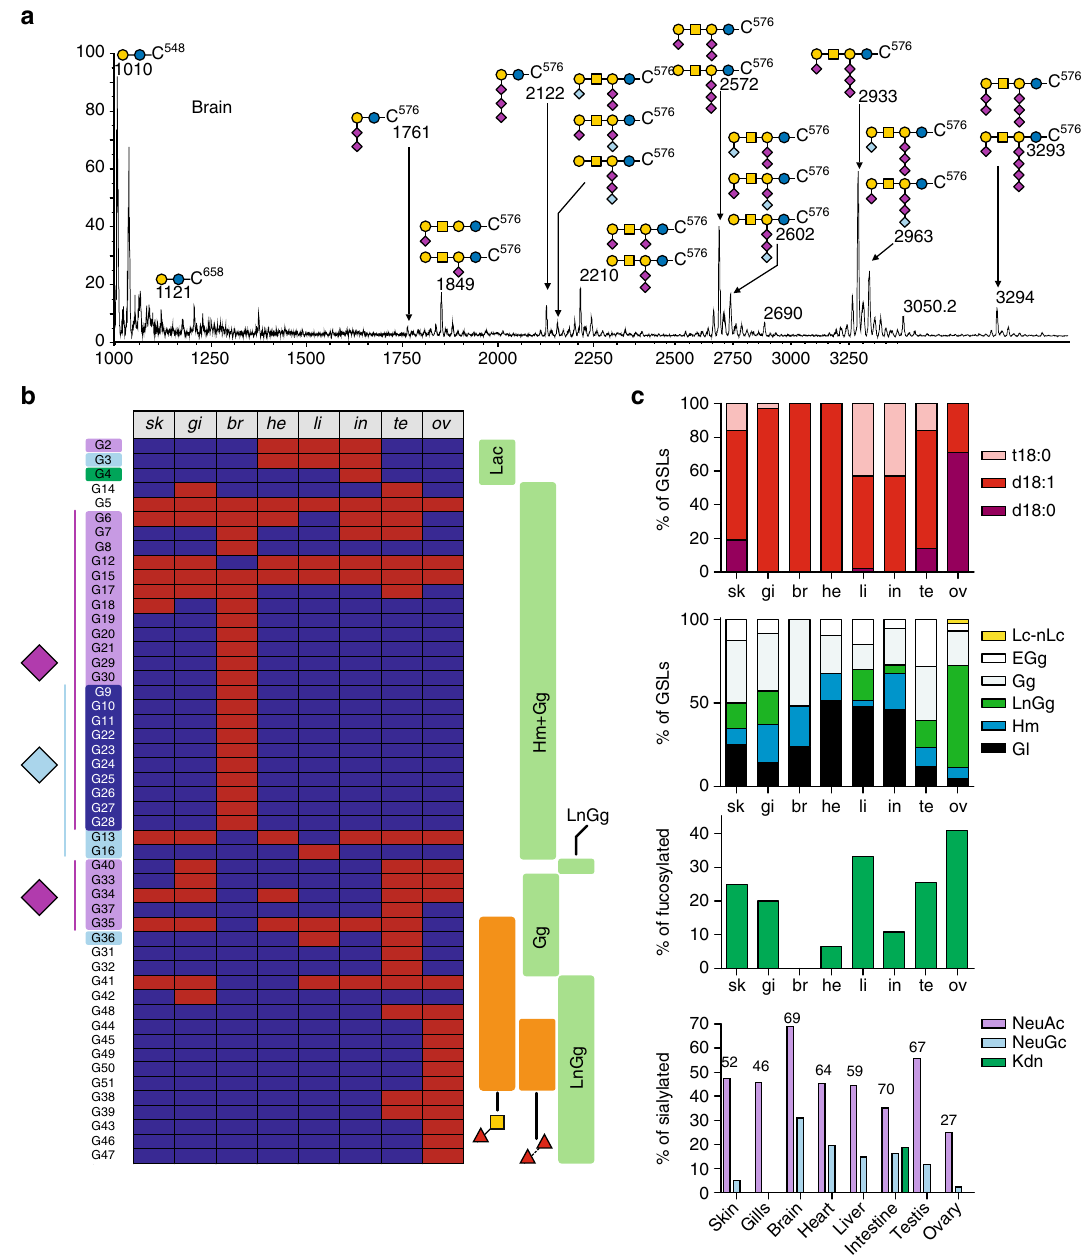
Fig. 6 Glyco-lipidome pro fi les. a Representative MALDI-TOF MS spectra of permethylated GSLs isolated from brain. All MS spectra are provided in Supplementary Figure 6. b Tissue-speci fi c distribution of the glycan moieties of GSLs according to following glycan epitopes: nature of substituting sialic acids (Neu5Ac, Neu5Gc, Kdn), the GSL families (Lacto; hemato and ganglio Hm + Gg; extended galglio ExGg; lacto-ganglio LnGg), Fuc α 1,3GalNAc β , and oligo-fucosylation. The presence of multiple ceramides prevents reliable quanti fi cation. The identi fi ed species are depicted in red and the non-detected ones in dark-blue. c From top to bottom panels: distribution of ceramides expressed as the percentage of GSLs bearing one or the other sphingoïd base (dark red bars, d18:0; medium red bars, d18:1; light red bars, t18:0); distribution of families expressed as the percentage of GSLs from one or the other family; occurrence of fucosylation expressed as the proportion of GSLs substituted by at least one fucose residue; sialylation pattern expressed as the percentage of GSLs substituted by any of the three sialic acids (purple bar, Neu5Ac; light blue bars, Neu5Gc; green bars, Kdn); numbers indicate the overall percentage of sialylated GSLs relative to total GSLs in the corresponding organs. It should be noted that a single GSL may harbor different types of